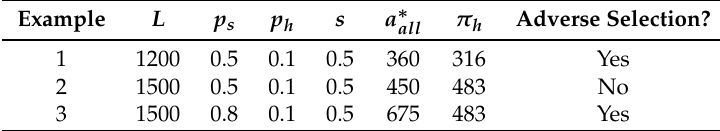
Table 1. Parameter values for Bernoulli numerical examples in the